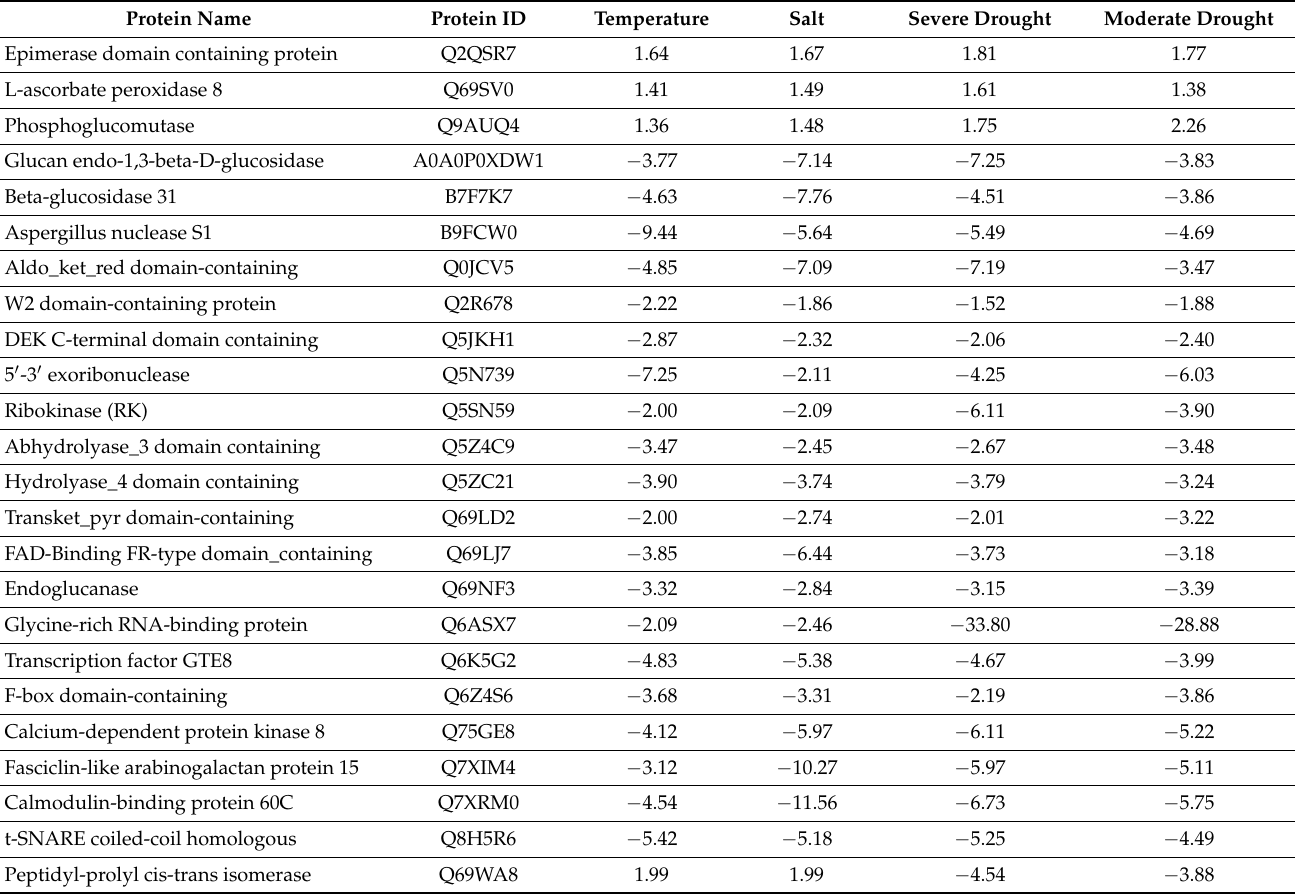
Table 4. Relative abundance level of DAPs involved in three abiotic stresses including severe drought, moderate drought, salt, and temperature stresses in Nipponbare